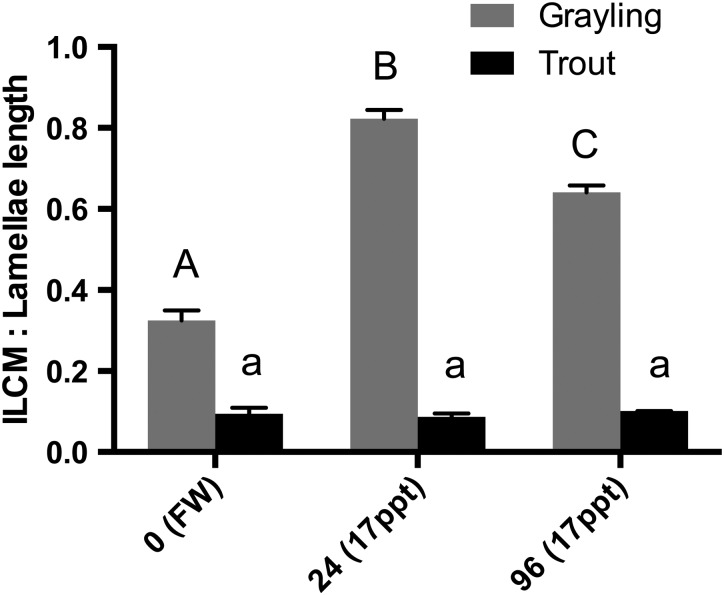
Measurements of the interlamellar cell mass (ILCM) of Arctic grayling and rainbow trout exposed to freshwater (FW; control) and 17 ppt saline water at 24 and 96 h. Grayling (grey bars) and rainbow trout (black bars) values indicate means + SEM, with significance demonstrated by dissimilar letters using one-way ANOVA. Capital letters denote grayling significance in comparison to grayling in freshwater, whereas lowercase letters denote rainbow trout significance (n = 3, P < 0.05, one-way ANOVA).